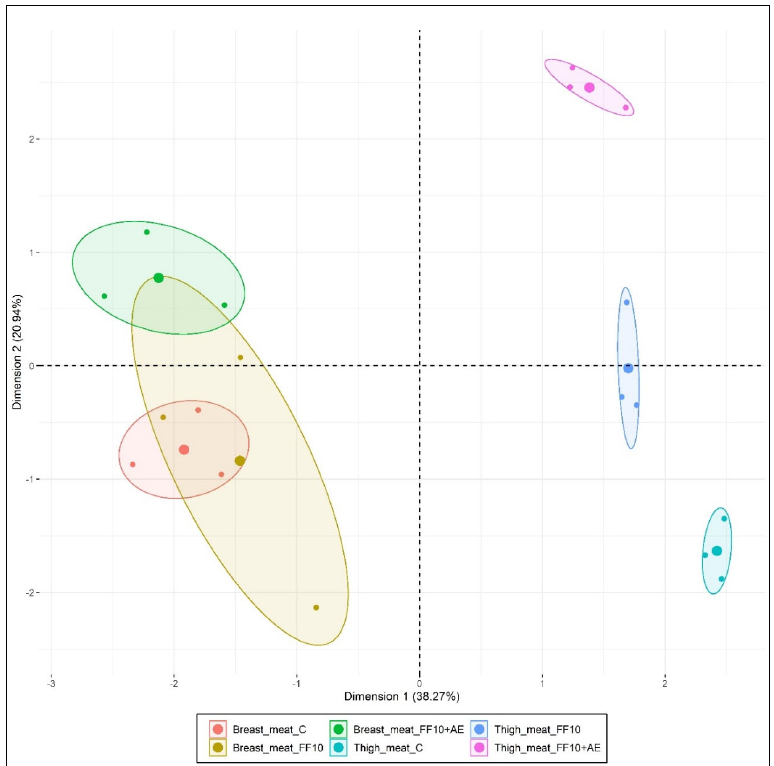
Figure 4. Multiple factor analysis plot of breast and thigh meat samples. C: control group; FF10: broilers fed with a diet enriched with supplementation of 10% FF; FF10 + AE: broilers fed with a diet enriched with 10% supplementation of FF supported with 0.2% agrimony extract.